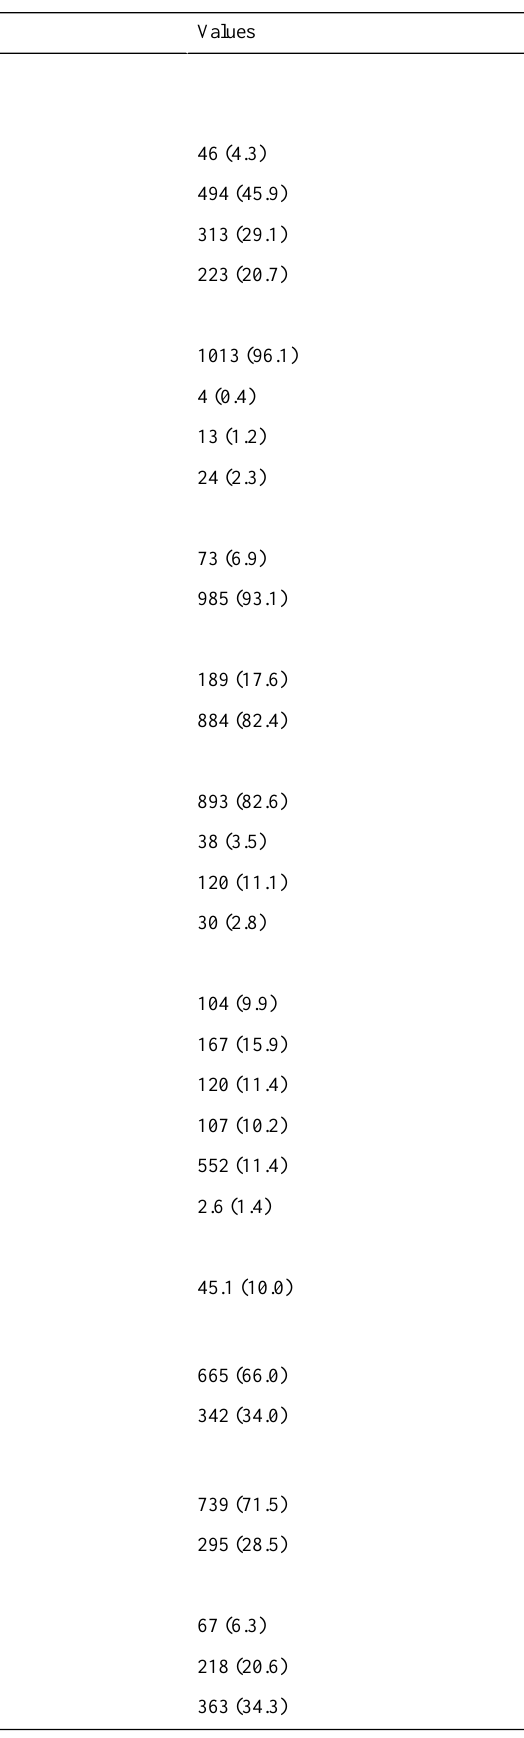
Table 1. Sample characteristics and mental health and well-being